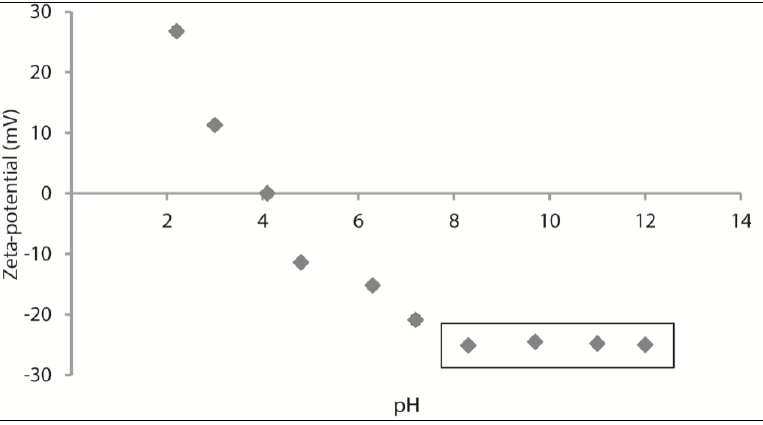
Figure 1. Zeta-potential of grass pea flour suspension as function of pH. Values in the frame represent the Zeta-potential range of stability. Table 1. Average size, polydispersity index and Zeta-potential of FFSs treated or not by mTGase. Sample pH 9 Average Size (d/nm)